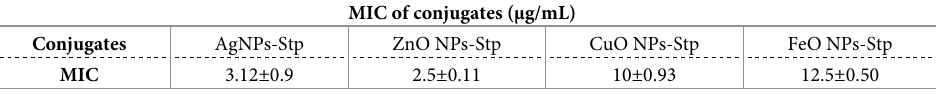
Table 3. Determinations of minimum inhibitory concentration ( μ g/mL) of prepared conjugates against S . aureus .